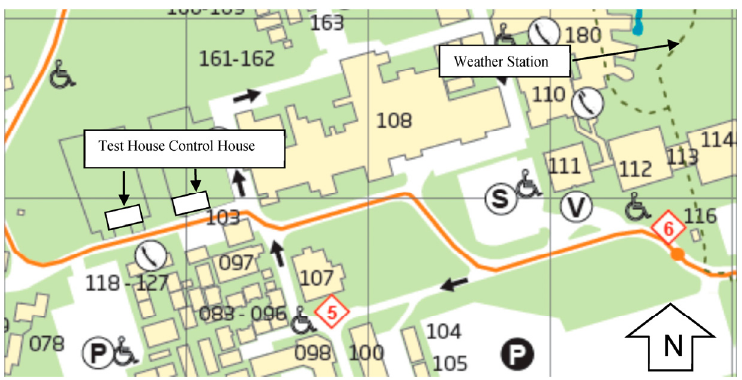
Figure 7. House plan with sensor locations.